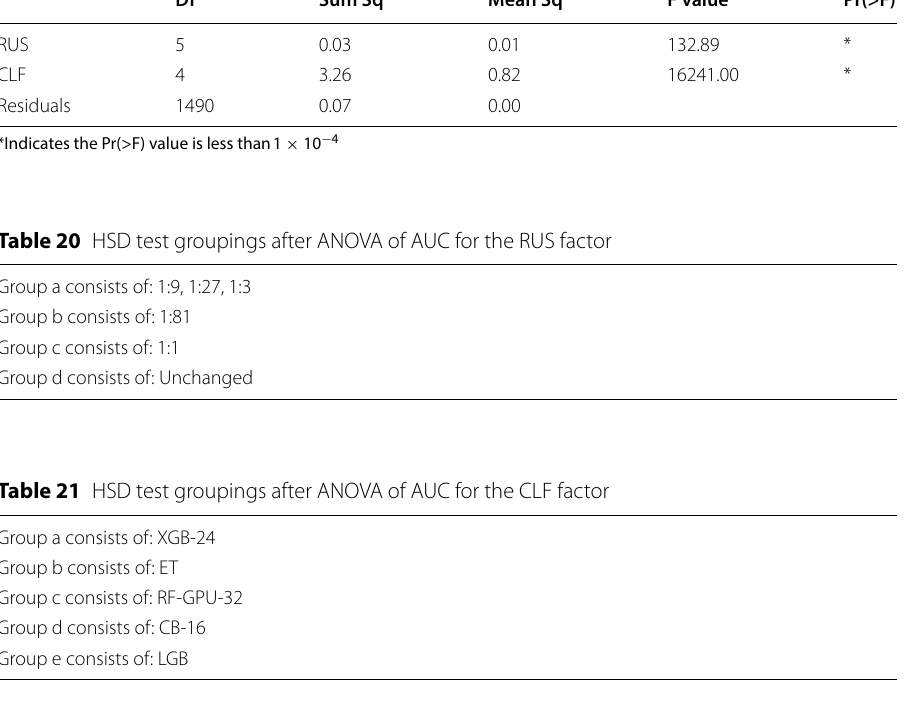
Table 19 ANOVA for RUS and CLF as factors of performance in terms of AUC Df Sum Sq Mean Sq F value Pr(>F) RUS